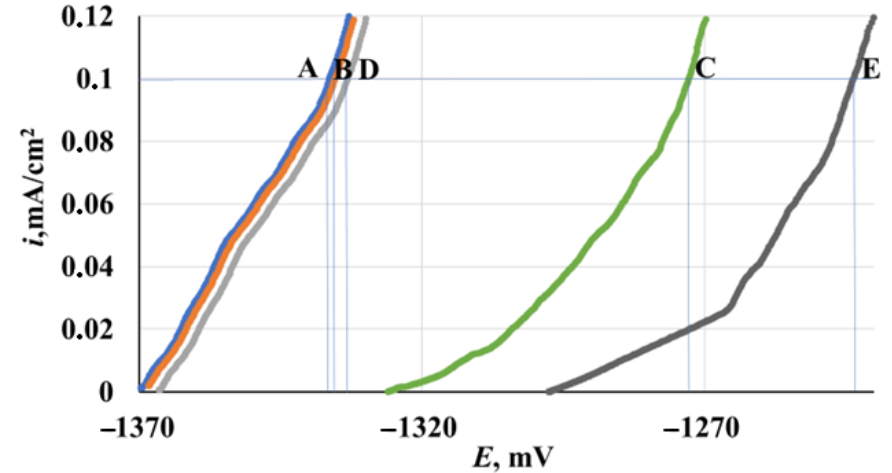
Figure 3. Anodic polarization curves of electrodes treated in modes A , B , C , D and E . Irrespective of the conditions for the preparation of the magnesium alloy, the polariza- tion curves show two nearly linear regions of i increase. The first one has a relatively small slope, whereas the second one is characterized by a sharp i increase. It is hardly possible to reliably attribute the former region to the alloy dissolution from the passive state and the latter one to local dissolution, as it is often the case for passive metals. The i values already reach considerable values in the first region of the anodic polarization curves. In this case, the surface of the metal removed from the electrolyte is heavily etched and is covered with a dark gray deposit. This prevents a visual identification of local metal dissolution sites in the second linear region of the polarization curves. It should be noted that small current oscillations are present throughout the entire length of the anodic po- larization curves. It may be assumed that they result from hydrogen bubbles on the elec- trode surface that are formed due to the negative difference effect and/or chemical disso- lution of the magnesium alloy. The polarization curves of magnesium prepared in modes A , B , and D are quite sim- ilar. Their characteristic values are nearly the same ( E st and E i are −1.37 and −1.34 V, re- spectively). The character of the anodic polarization curves on electrodes treated in CBTA vapors (preparation modes C and E ) changed somewhat. The initial region had a smaller slope with respect to the abscissa axis. The polarization curves themselves shifted to the anodic region due to the inhibition of the anodic process. The i values decreased abruptly in the entire potential range studied. Moreover, the preparation mode E resulted in much lower i values compared to mode C . With an increase in τ exp , ennoblement of both E st and E i was observed. Thus, comparison of the voltam metric plots of electrodes prepared in modes A , B and D shows that TT of samples does not affect the anodic behavior of the magnesium alloy, regardless of τ exp . This fact agrees with the results of the corrosion tests reported above. Chamber treatment of electrodes slows down the anodic process ( cf . the samples pretreated in modes B and C ). It is noteworthy that exposure of the samples in air after CT (preparation modes C and E ) causes additional inhibition of the anodic process. 3.3. Electrochemical Impedance Spectroscopy Additional information on the mechanisms and kinetics of the structuring processes in surface films on the magnesium alloy is provided by electrochemical impedance spec- troscopy. The Nyquist plots of electrodes treated in modes A , B , C , D and E are shown in Figure 4.